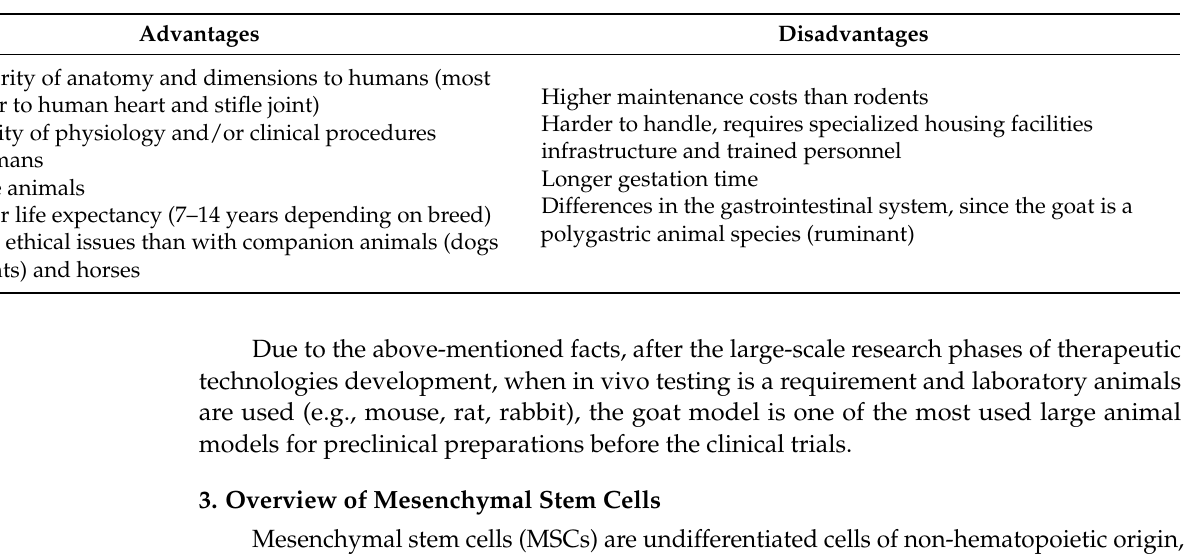
Table 1. Advantages and disadvantages of the goat model